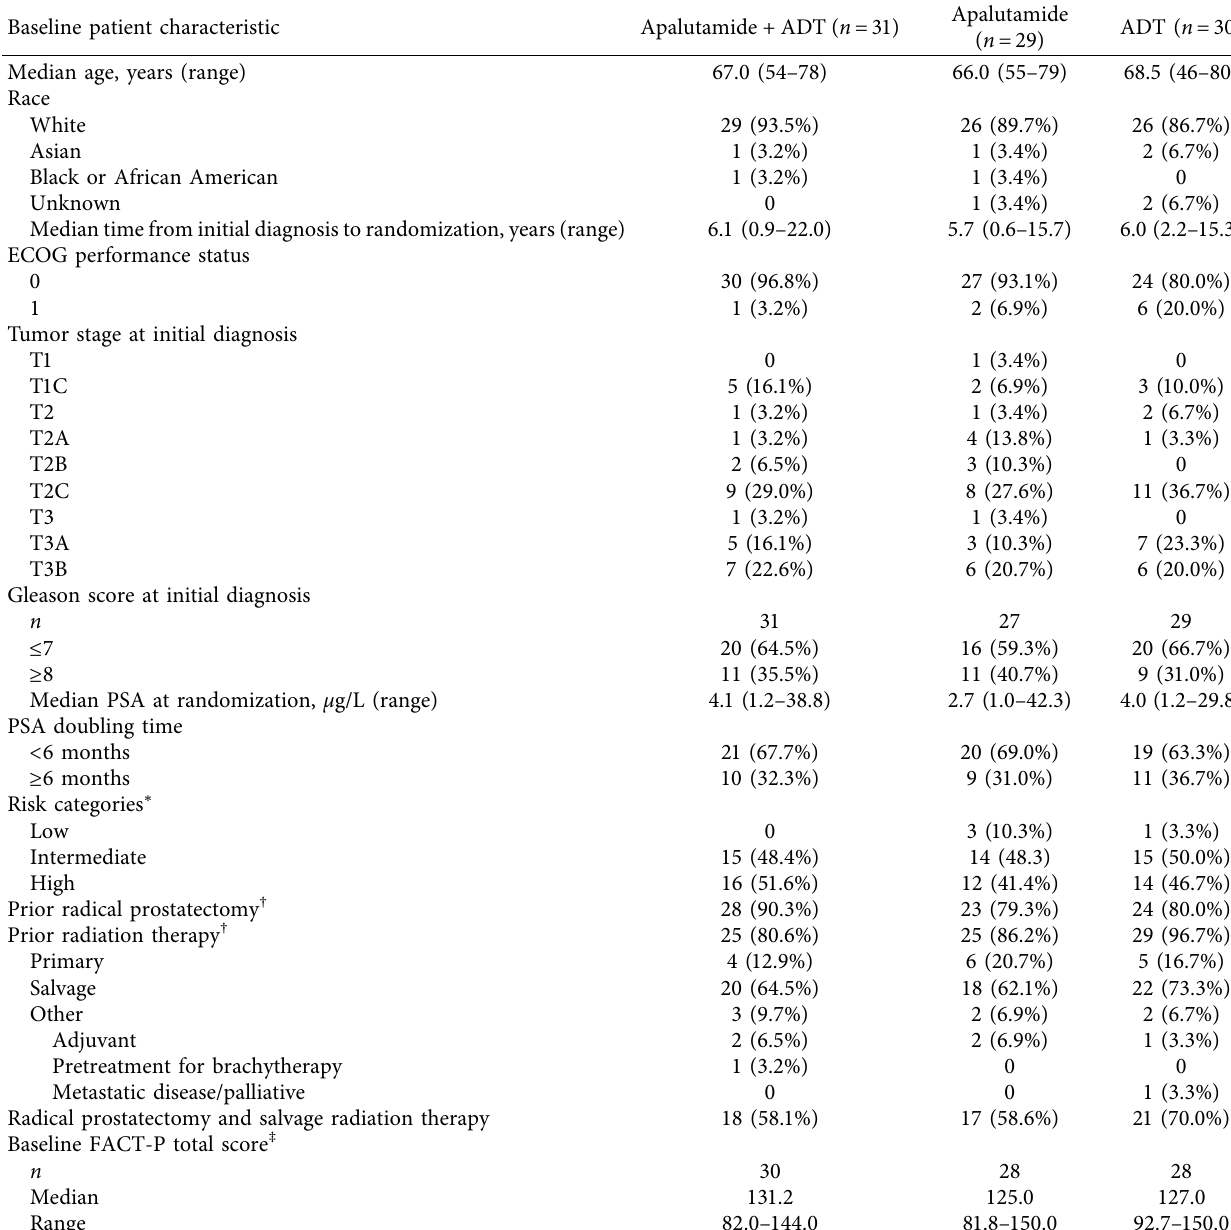
Table 3: Demographic and baseline characteristics (intent-to-treat